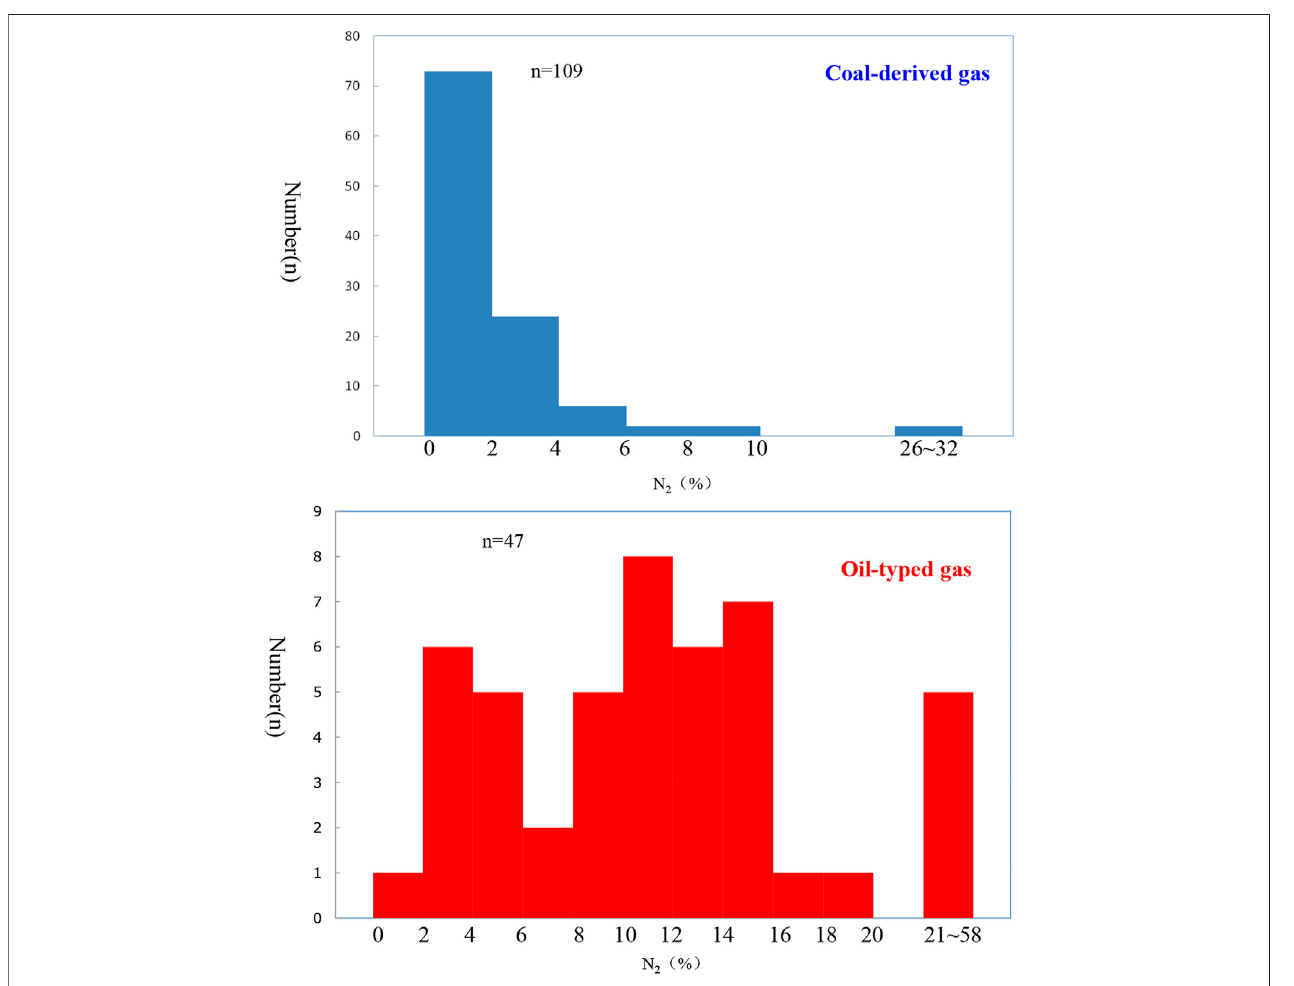
FIGURE 2 | Nitrogen content distributions in coal-derived gas and oil-typed gas in China.